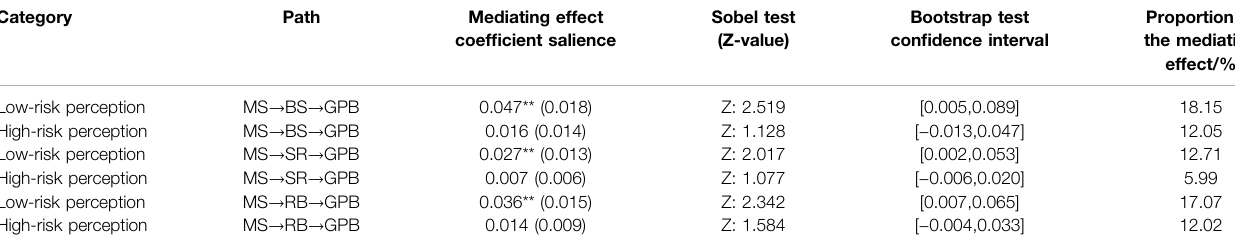
TABLE 5 | Subsample mediation test of membership status.